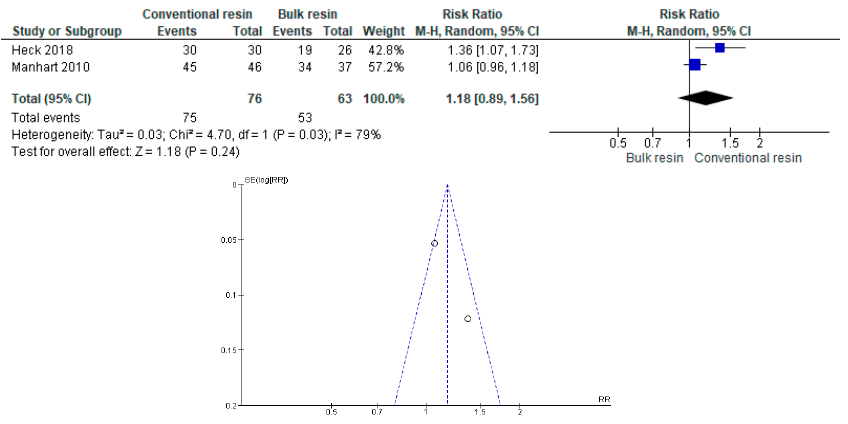
Figure A44. Adequate Restoration Integrity: Conventional Resin versus Bulk Resin.